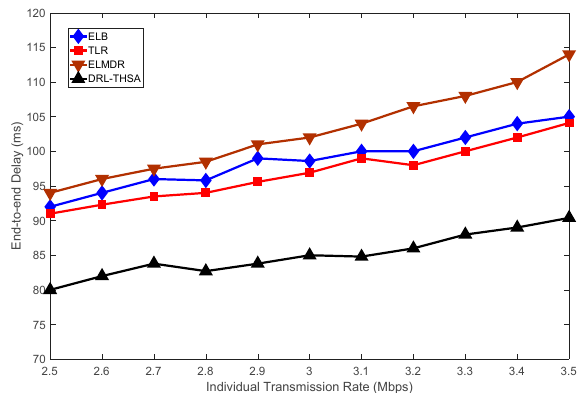
Figure 4. The average end-to-end delay with di ff erent transmission rates.